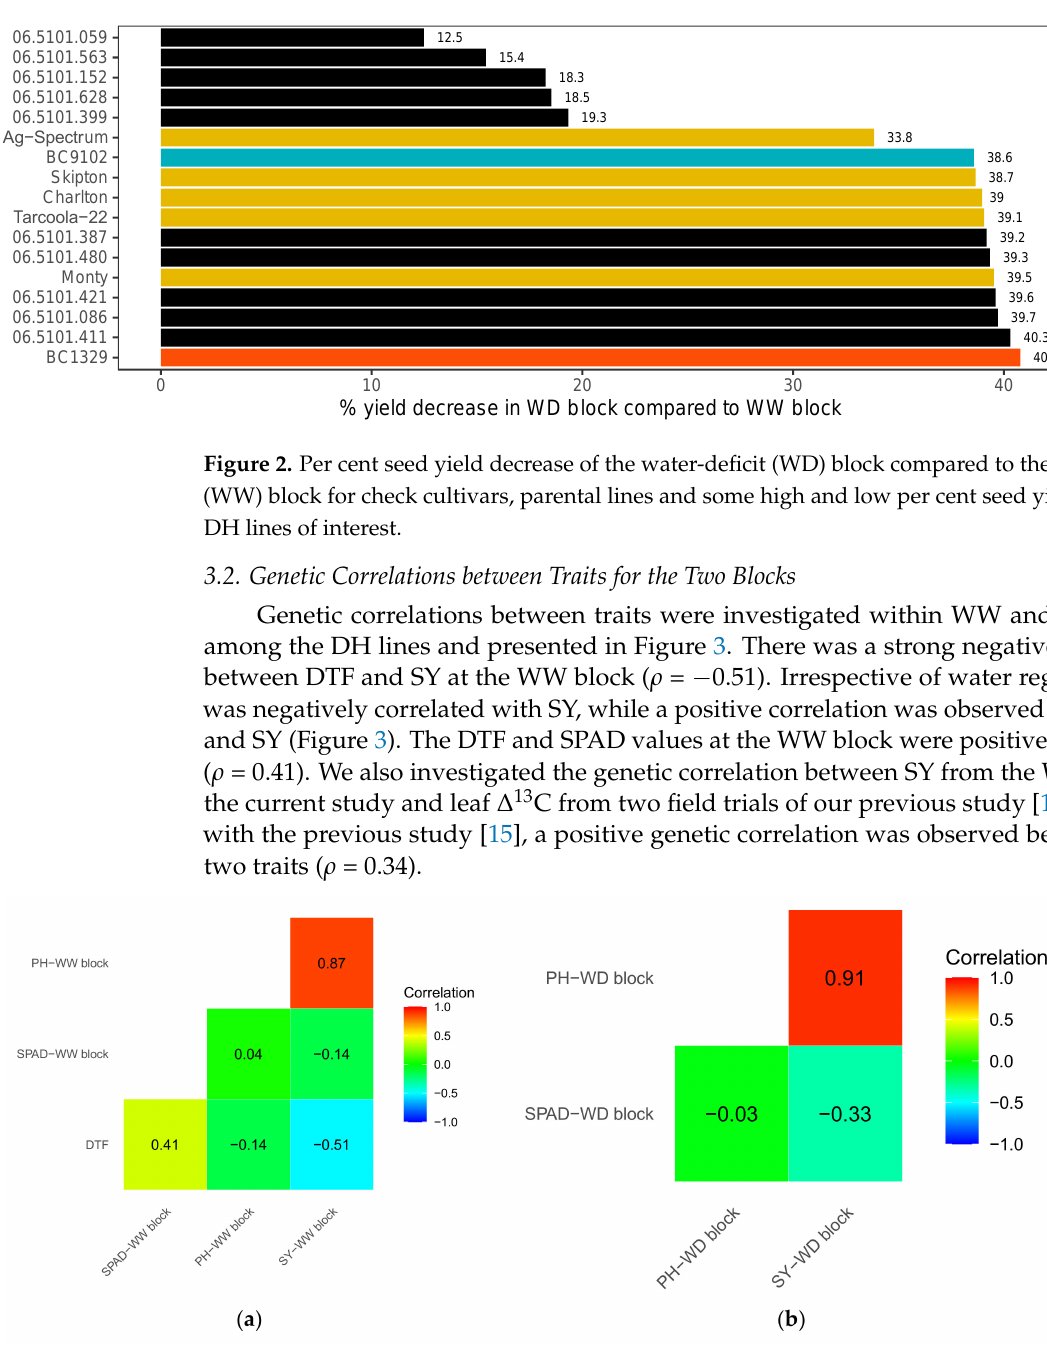
Figure 3. Genetic (total, additive plus non-additive) correlations between traits ( a ) within well- watered (WW) and ( b ) within water-deficit (WD) blocks from the multivariate analyses. SY: Seed yield; PH: Plant height; SPAD: Chlorophyll content; DTF: Days to